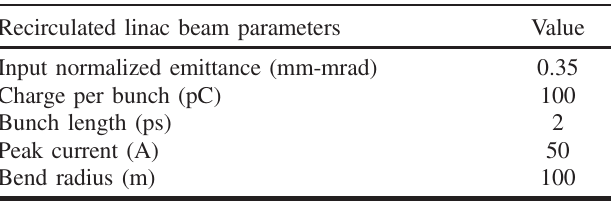
TABLE I. Recirculated linac beam